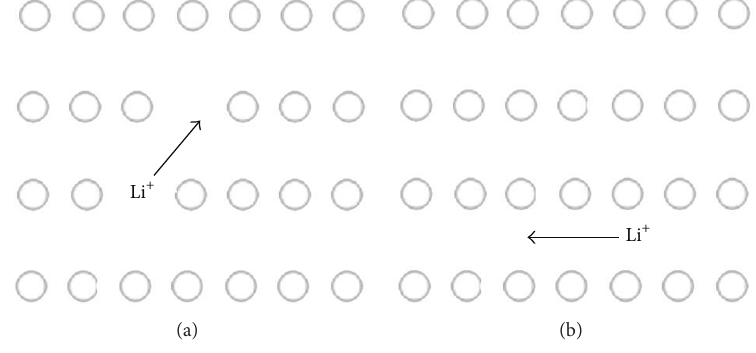
Figure 6: Grain lattice diffusion: (a) substitutional diffusion and (b) interstitial